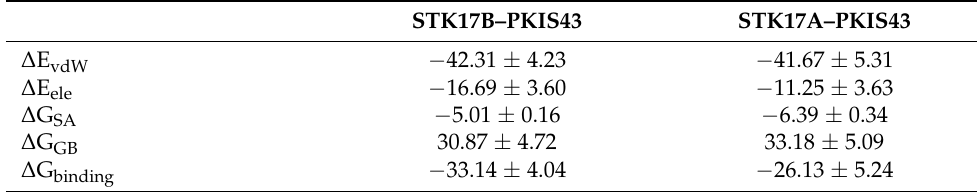
Table 1. Binding free energy (kcal/mol) between PKIS43 and STK17B and STK17A.